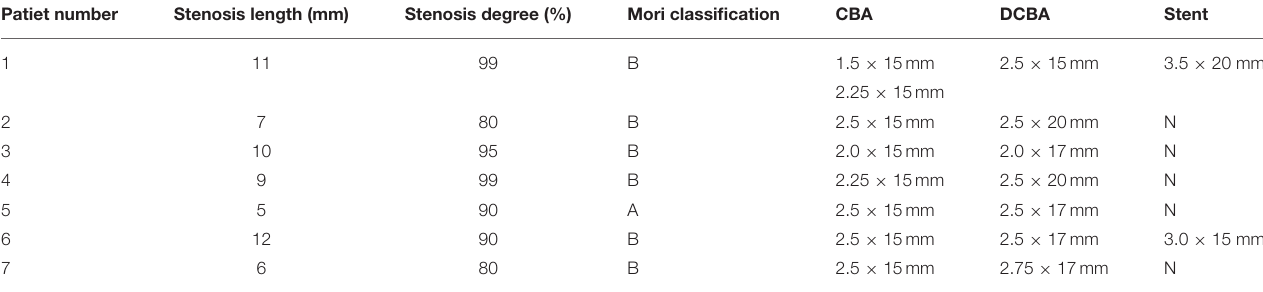
TABLE 2 | Angiographic and procedural characteristics.